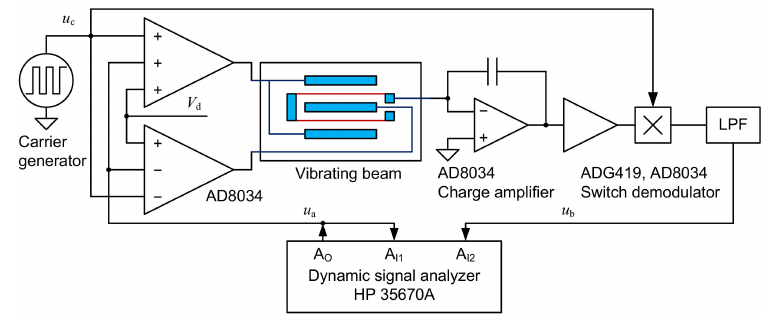
Figure 6. Test circuit and